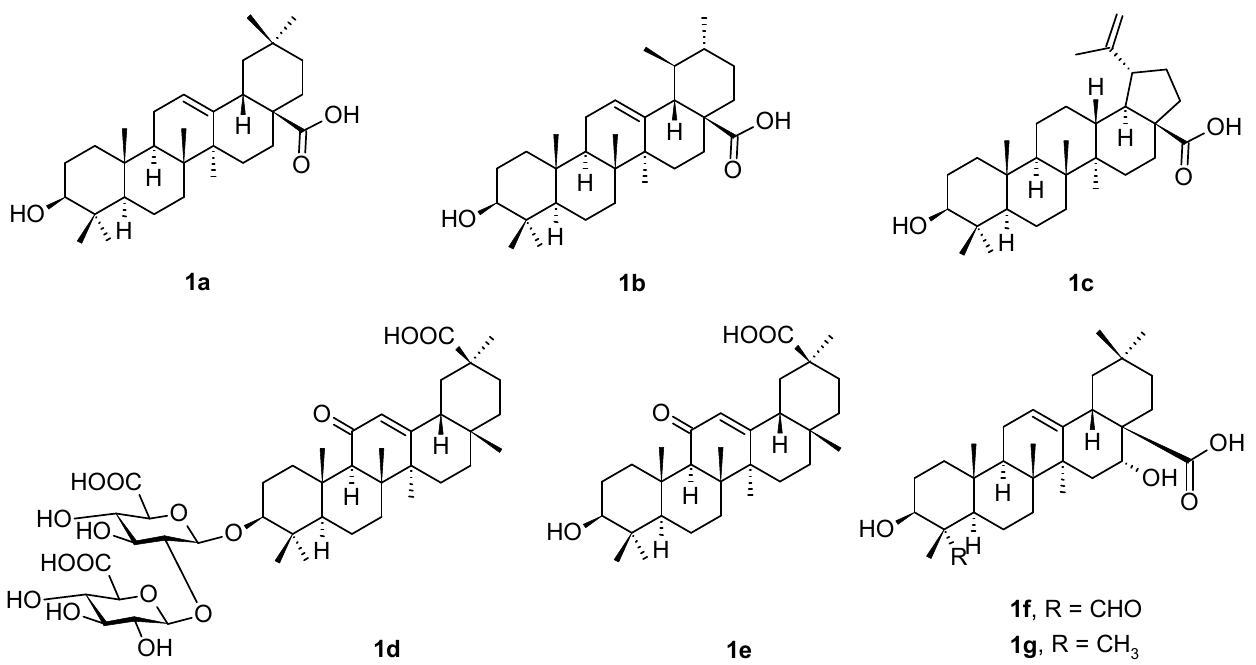
Figure 1. The structures of selected natural triterpenoids.